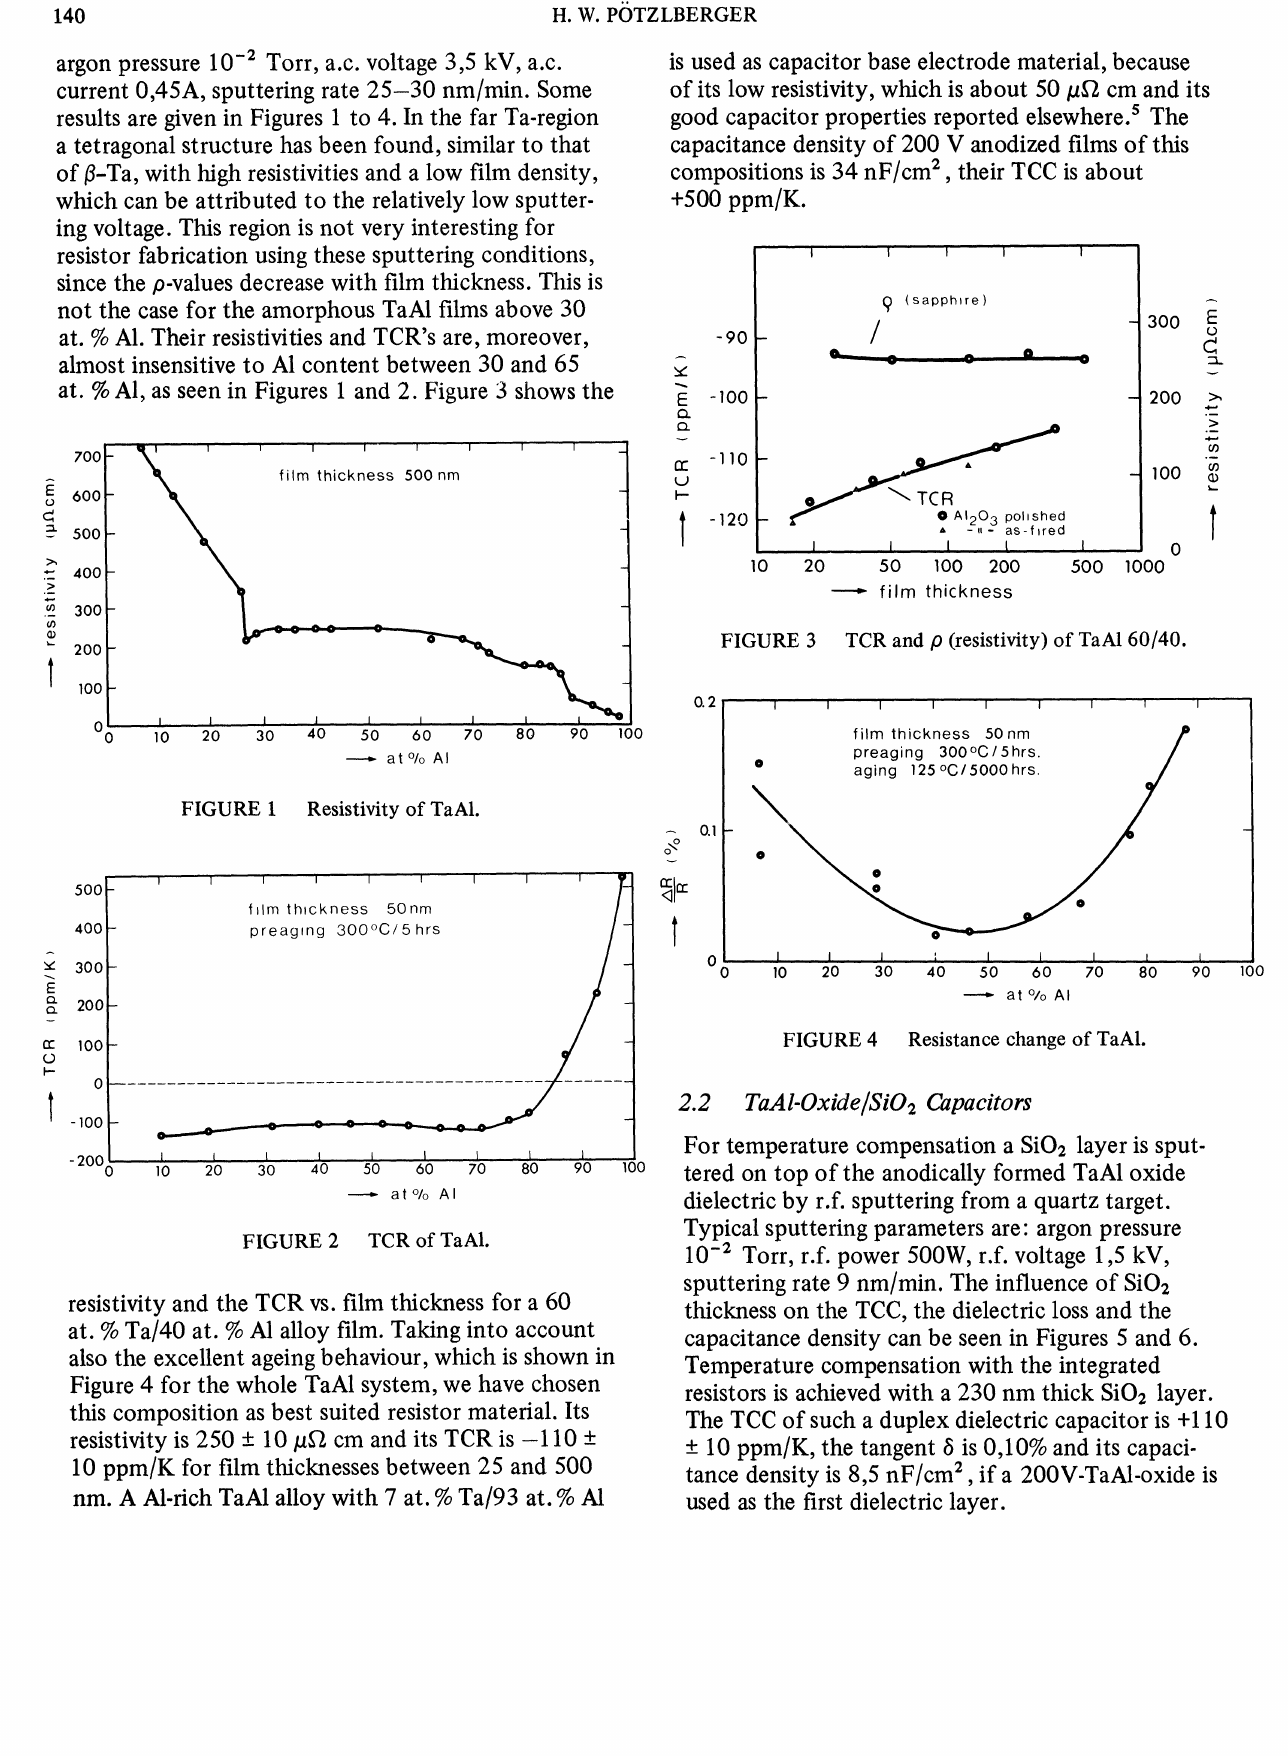
FIGURE 4 Resistance change of TaA1. 2.2 TaAl-Oxide/SiOz Capacitors For temperature compensation a SiO2 layer is sput- tered on top of the anodically formed TaA1 oxide dielectric by r.f. sputtering from a quartz target. Typical sputtering parameters are" argon pressure FIGURE 2 TCR of TaA1. 10 -: Torr, r.f. power 500W, r.f. voltage 1,5 kV, sputtering rate 9 nm/min. The influence of SiO2 thickness on the TCC, the dielectric loss and the capacitance density can be seen in Figures 5 and 6. Temperature compensation with the integrated resistors is achieved with a 230 nm thick SiO: layer. The TCC of such a duplex dielectric capacitor is +110 +-- 10 ppm/K, the tangent 6 is 0,10% and its capaci- tance density is 8,5 nF/cm if a 200V-TaAl-oxide is used as the first dielectric